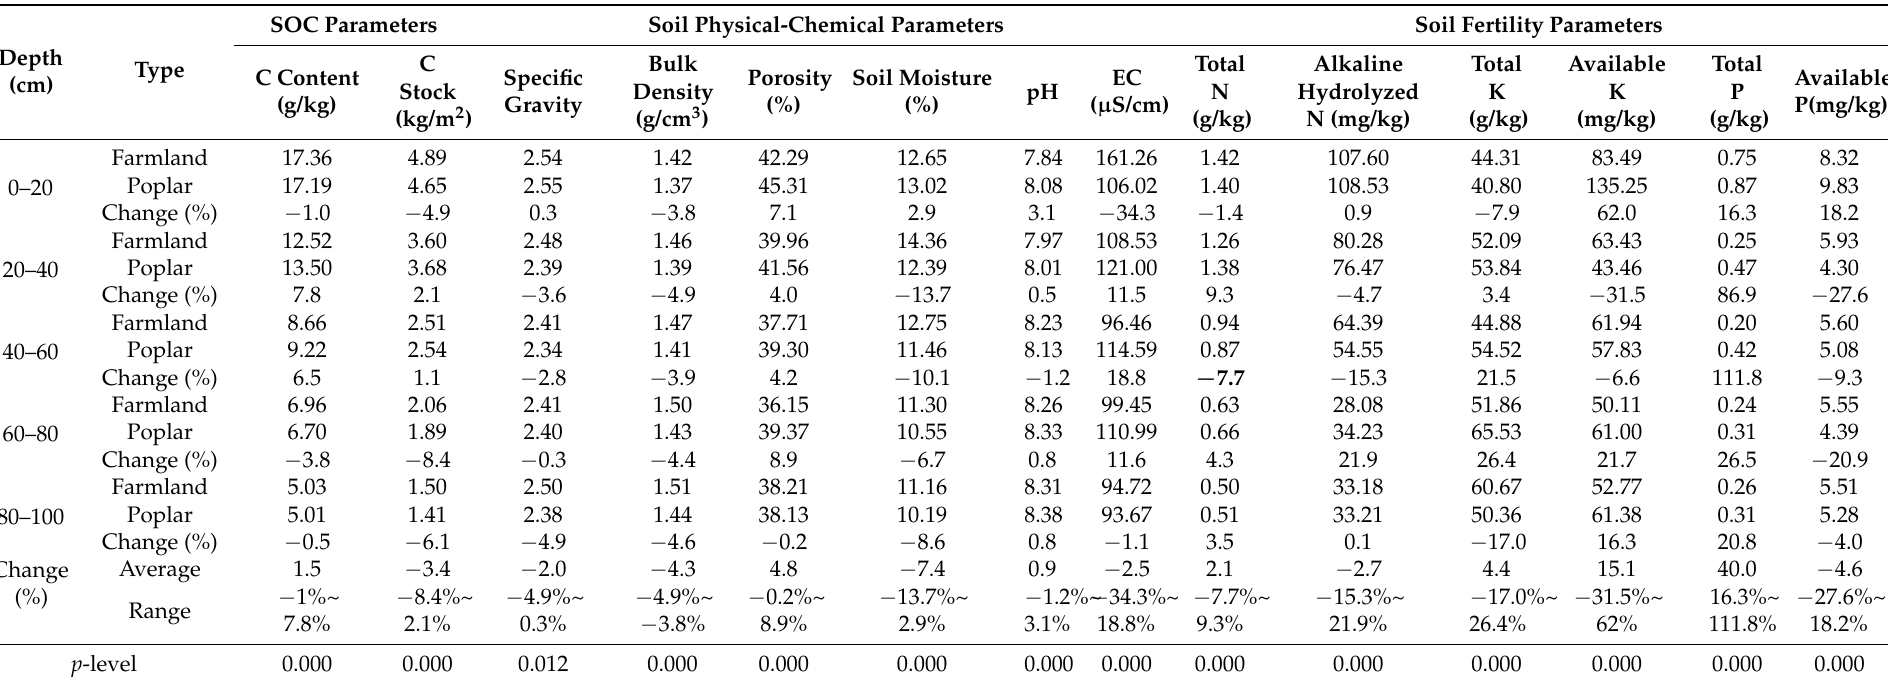
Table 4. Shelterbelt construction and sampling depth significantly affected 14 soil parameters (marked type*depth interaction, p < 0.05) and the magnitudes and pattern of the influences. The non-significant factors ( p > 0.05) were not listed